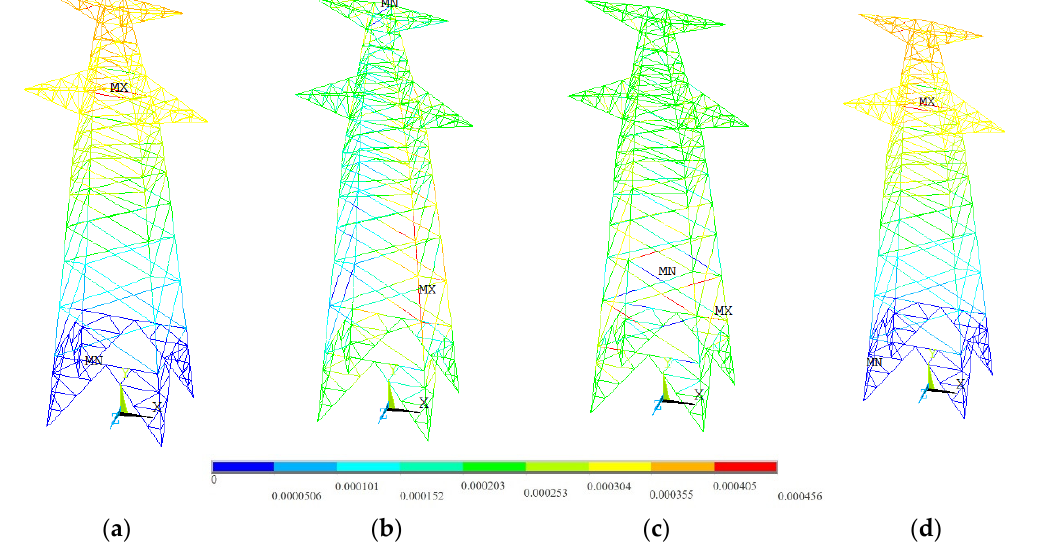
Figure 7. Rotation of the transmission tower in the first order vibration mode with settlement; ( a – c ) are for the X, Y and Z directions, respectively, and ( d ) is for the sum vector result.